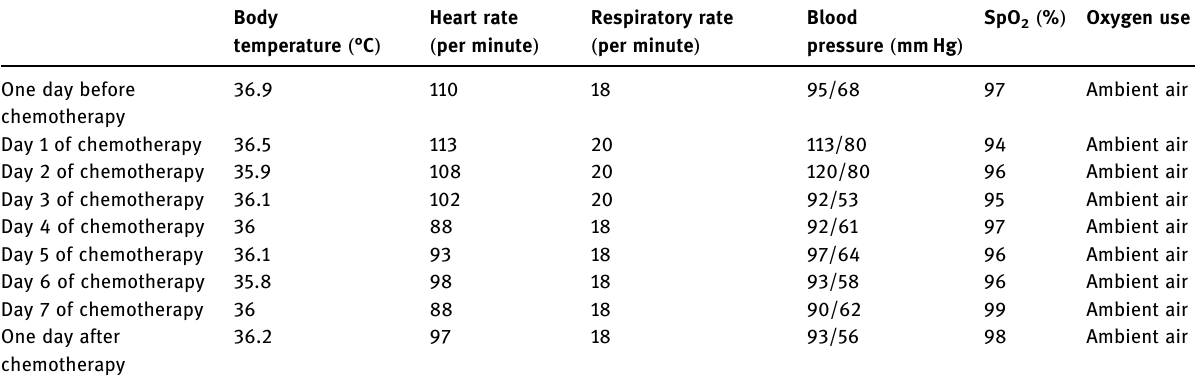
Table A1: Vital signs before, during and after the induction chemotherapy